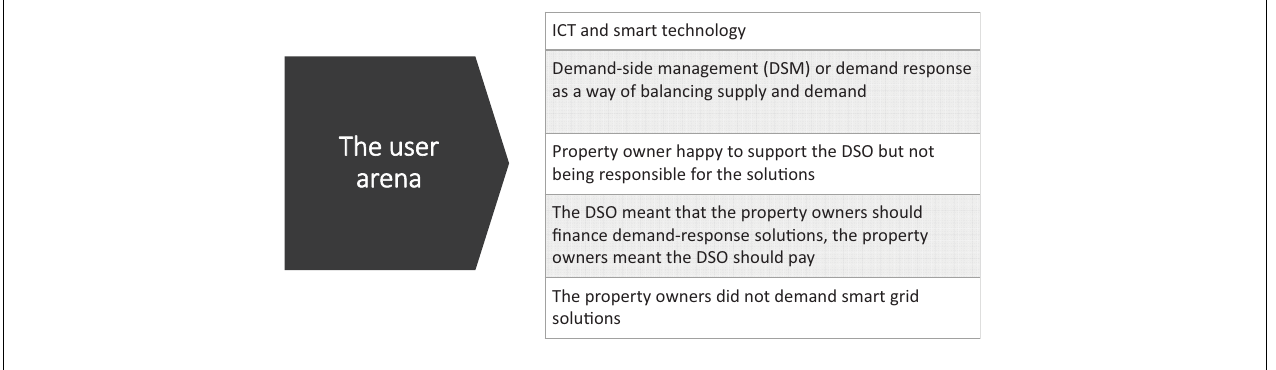
FIGURE 5 | A summary of the main findings in the user